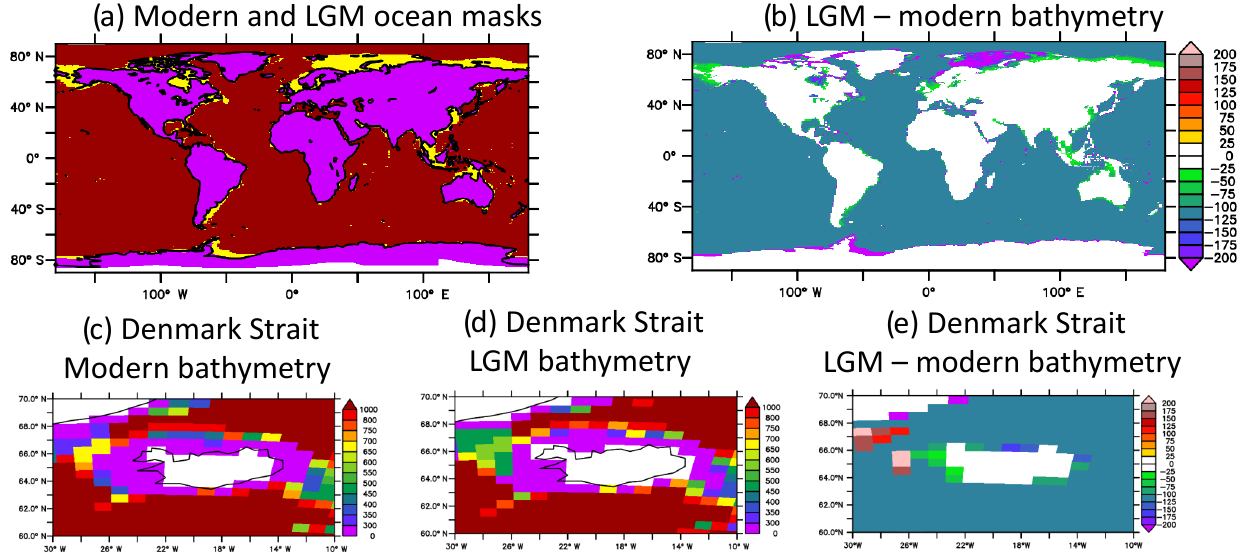
Figure 5. Checking the bathymetry and coastlines (example of figures obtained with the ferret script verif_all.jnl provided in the Supple- ment). (a) Modern and LGM ocean masks (purple: continents in both modern and LGM configurations); yellow: continent in LGM config- uration, ocean in modern configuration; red: ocean in both modern and LGM configurations; (b) anomaly (LGM – modern) in bathymetry (m); (c, d, e) details for the Demark Strait/Iceland area; (c) modern bathymetry (m); (d) LGM bathymetry (m); (e) LGM – modern bathymetry anomaly